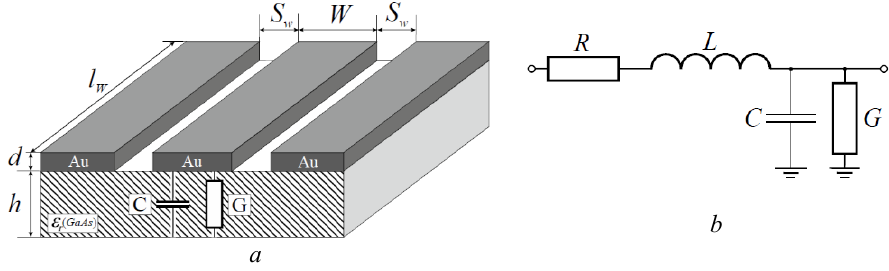
Figure 1. CML structure — a ) and its small-signal equivalent circuit — b